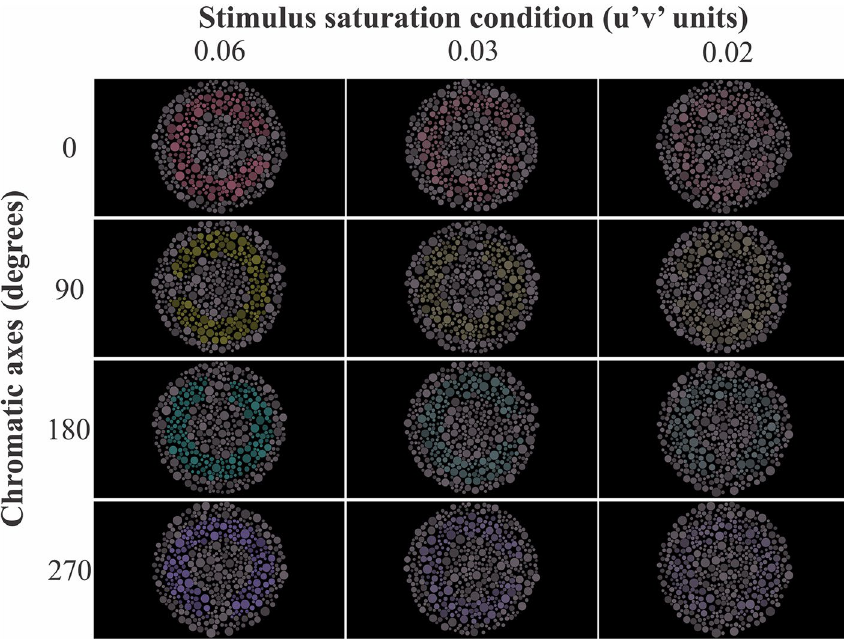
Figure 1. Examples of pseudoisochromatic stimuli for three chromatic saturations (0.06, 0.02, and 0.005) and four chromatic axes (0°, 90°, 180°,